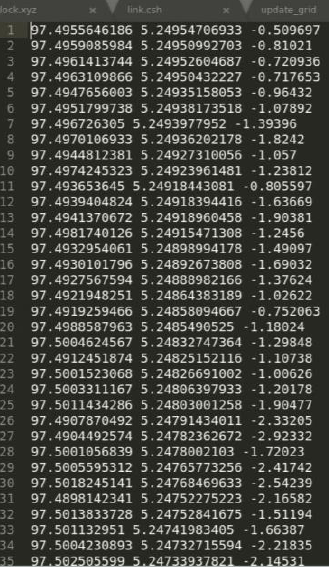
Figure 8. Height differences after corrected with operators error parameter.